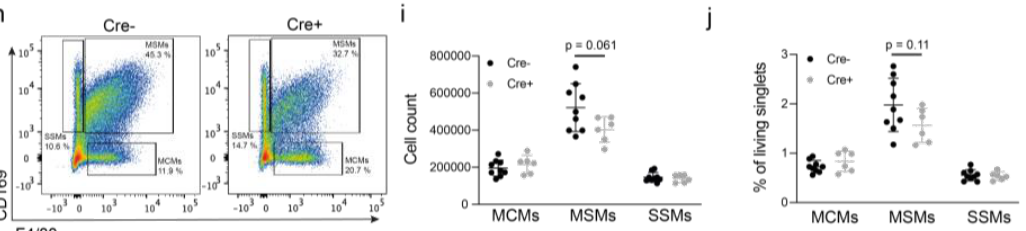
Figure 5. Lymphatic podoplanin regulates abundance of medullary sinus macrophages (MSMs) in tumor-draining lymph LNs. ( a ) Schematic representation of the experimental set-up. Pdpn fl/fl x Prox1-CreER T2 mice were treated for 5 consecutive days with tamoxifen. Cre − littermates served as controls. Subsequently, B16F10 cells were implanted intradermally, tumor growth was monitored, and tumor-draining LNs (inguinal and axillary) were analyzed by flow cytometry on day 14. ( b ) Representative LEC gating in Cre − and Cre+ mice. Stromal cells (pregated as CD45 − living singlets) were stained for podoplanin and CD31 to detect FRCs and endothelial cells, respectively. Subsequently, LECs were distinguished from BECs with a combination of CD41 (Itga2b) and ESAM. ( c , d ) Representative histogram ( c ) and quantification ( d ) of podoplanin expression in LN stromal cells ( N = 9 Cre − /7 Cre+). ( e ) Number of LN stromal cells in tumor-draining LNs determined by flow cytometry ( N = 9 Cre − /7 Cre+). ( f , g ) Representative images ( f ) and quantification ( g ) of CD169+ macrophages in subcapsular and medullary sinuses of tumor-draining LNs in Cre − and Cre+ mice ( N = 7/group for subcapsular and 5/group for medullary sinus). ( h – j ) Representative flow